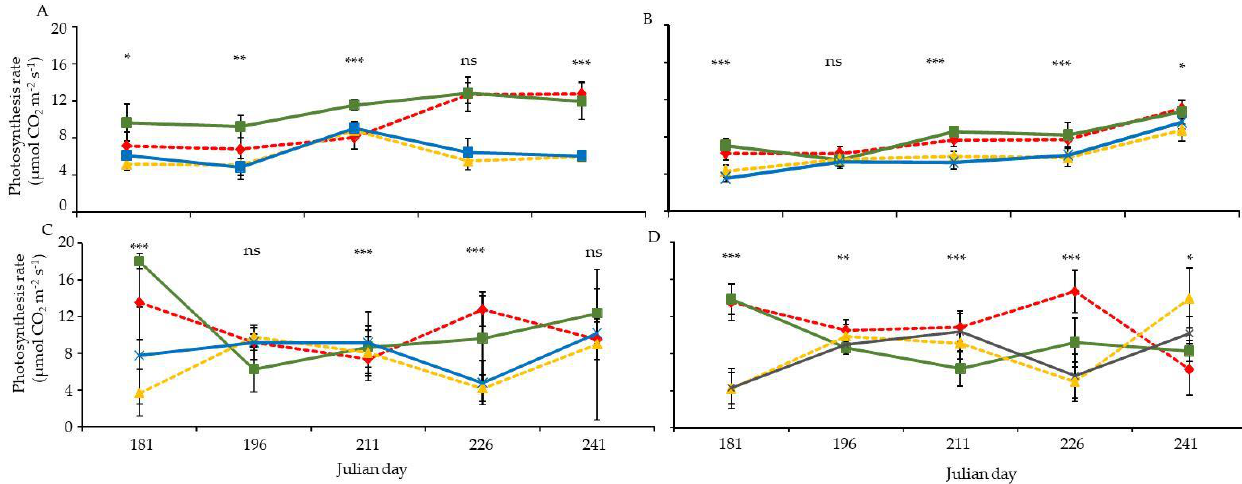
Figure 3. Net photosynthesis measured in 2017 (( A ) primary leaves, ( B ) lateral leaves) and 2018 (( C ) primary leaves, ( D ) lateral leaves) for the four combinations analyzed. For each year, *, ** and *** represent significant differences at p < 0.05, 0.01 and 0.001, respectively, and ns indicates no significant difference, based on Tukey’s HSD test ( ± standard deviation).